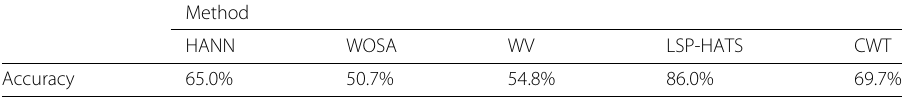
Table 3 Total classification accuracy obtained using features extracted with the different TF estimators in the simulation study, obtained on 10 independent simulations